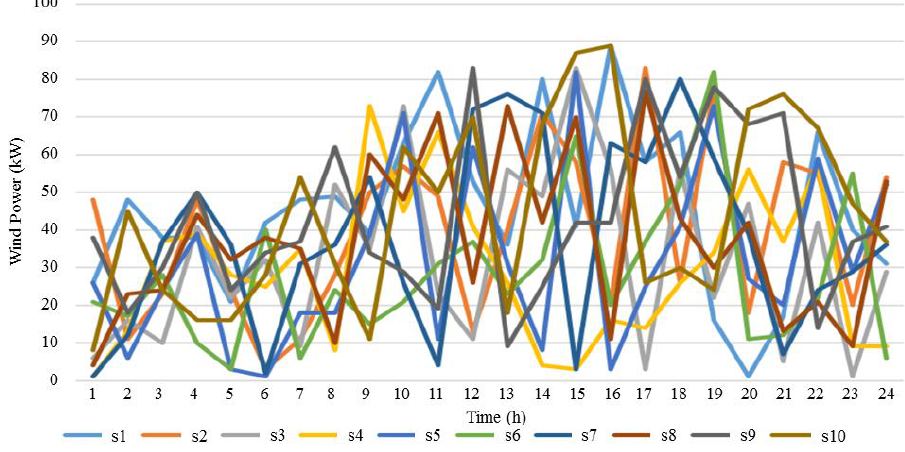
Figure 2. Wind power scenarios considered.